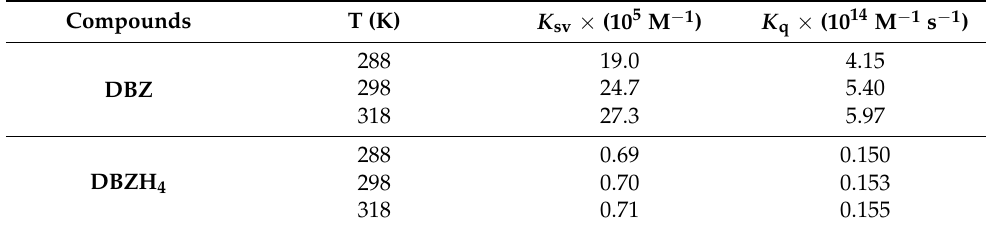
Table 1. The Stern–Volmer quenching constants ( K sv ) and quenching rate constants for the interaction of complexes DBZ and DBZH 4 with BSA at various